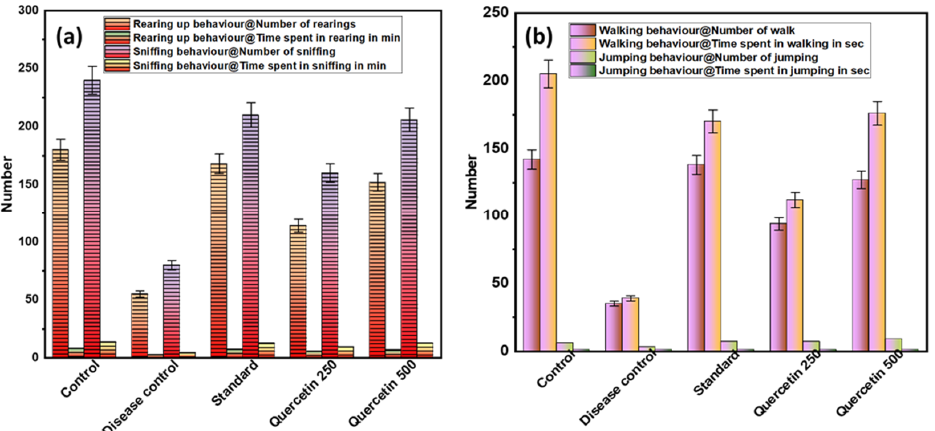
Figure 2. ( a ) Effect of Quercetin on rearing up and sniffing (exploratory behavior); ( b ) effect of Quercetin on walking and jumping (locomotor behavior).